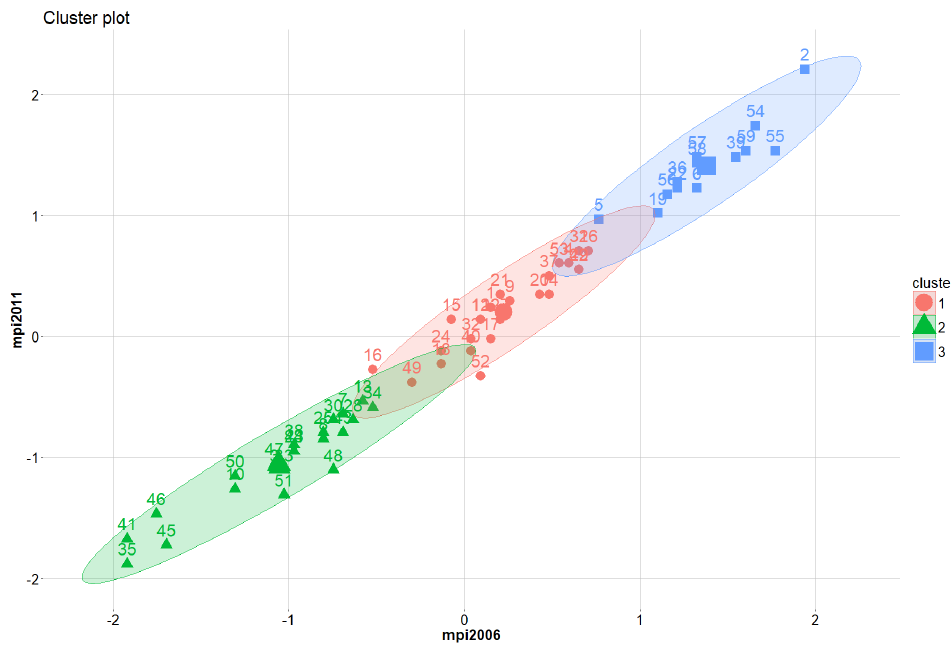
Figure 2: Scatter plots for k-means clusters’ solutions – k =